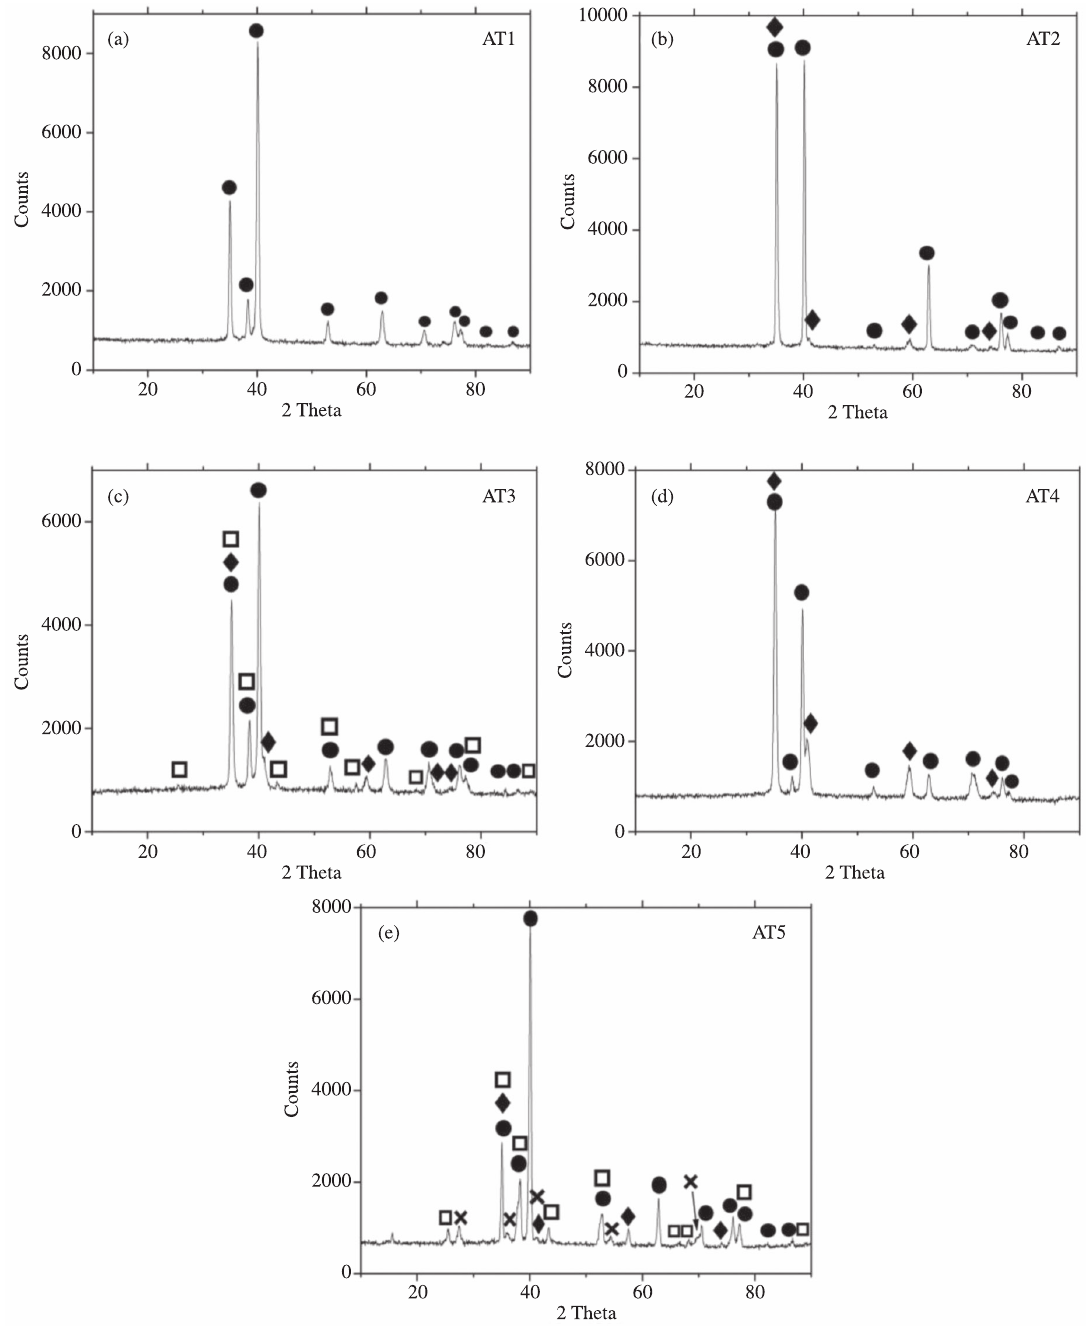
Figure 4. Typical GIXRD diffractograms of samples from groups AT1 to AT5 (a to e, respectively). Peak identification according to crystal structures: Ti (circle), TiH